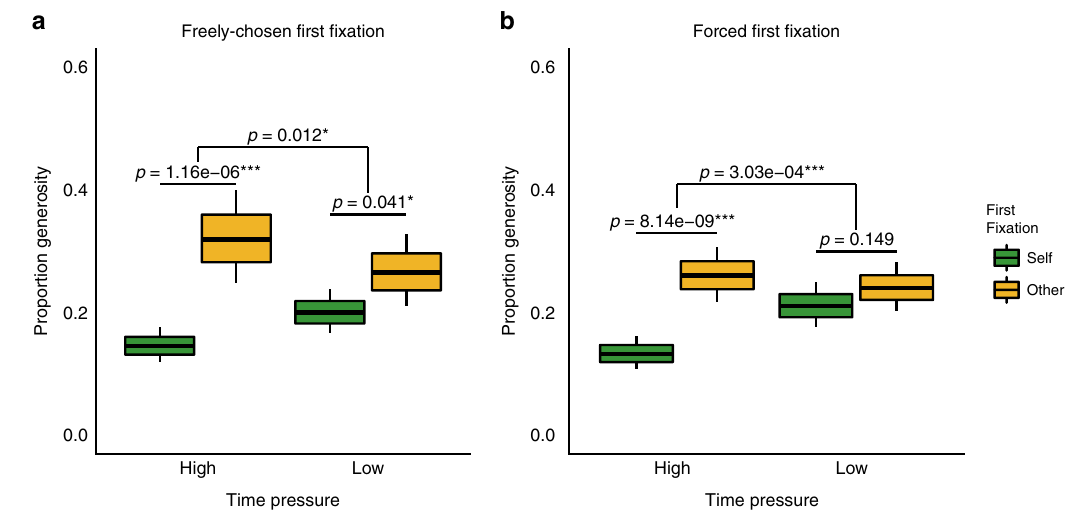
Fig. 7 First fi xation predicts generosity under time pressure but not time delay. Effects of fi rst fi xation on generosity moderated by time pressure in a free attention trials ( N = 200 subjects) and b forced attention trials ( N = 200 subjects). Central line in boxplots indicate estimated means and upper and lower bounds indicate one standard error above and below the mean, coloured by fi rst- fi xation position. The whiskers indicate the 95% con fi dence interval for the estimated mean. * p < 0.05, ** p < 0.01, *** p < 0.001 for two-tailed z -tests of the regression estimate. Source data are provided as a Source Data fi